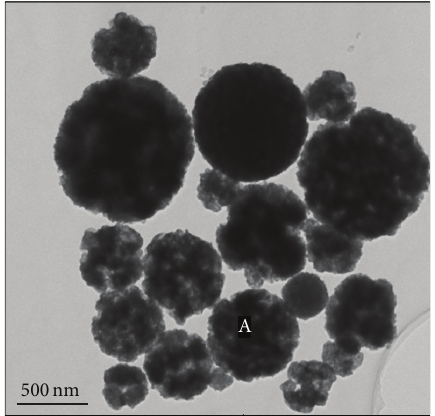
Figure 3: The TEM images of CdIn 2 S 4 prepared at 500 ∘ C.